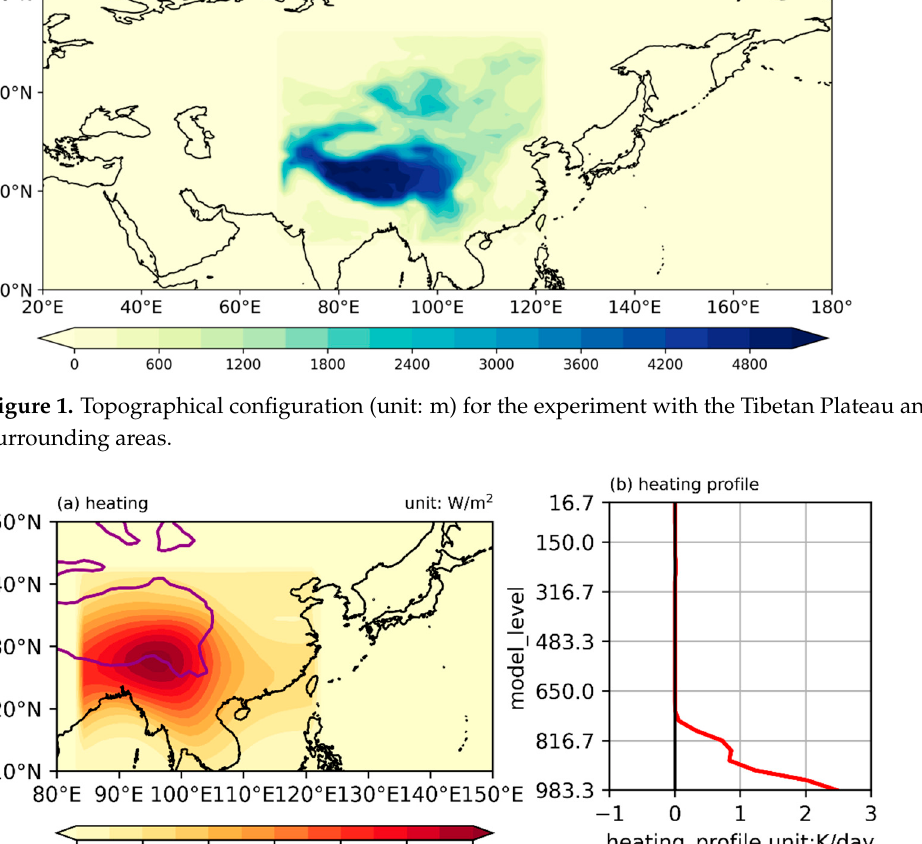
Figure 1. Topographical configuration (unit: m) for the experiment with the Tibetan Plateau and its surrounding areas.